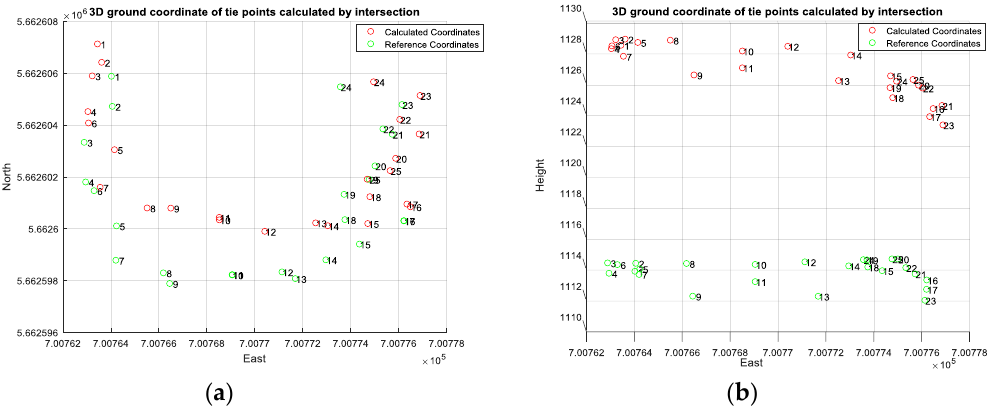
Figure 12. ( a ) Horizontal coordinate of OPs based on intersection; ( b ) Vertical coordinate of OPs based on intersection.